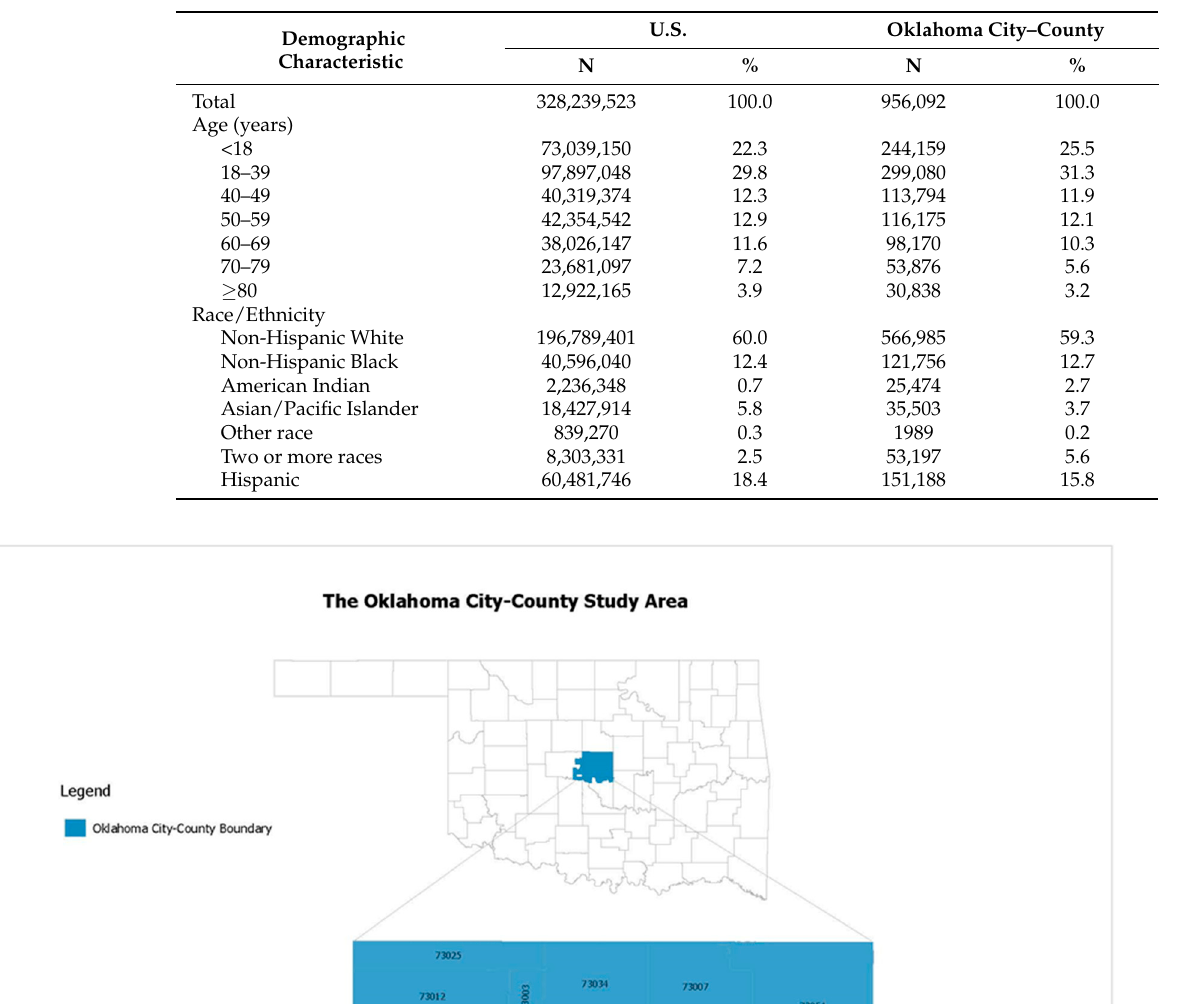
Table A1. Distribution of age and race/ethnicity in the United States and Oklahoma County [13].